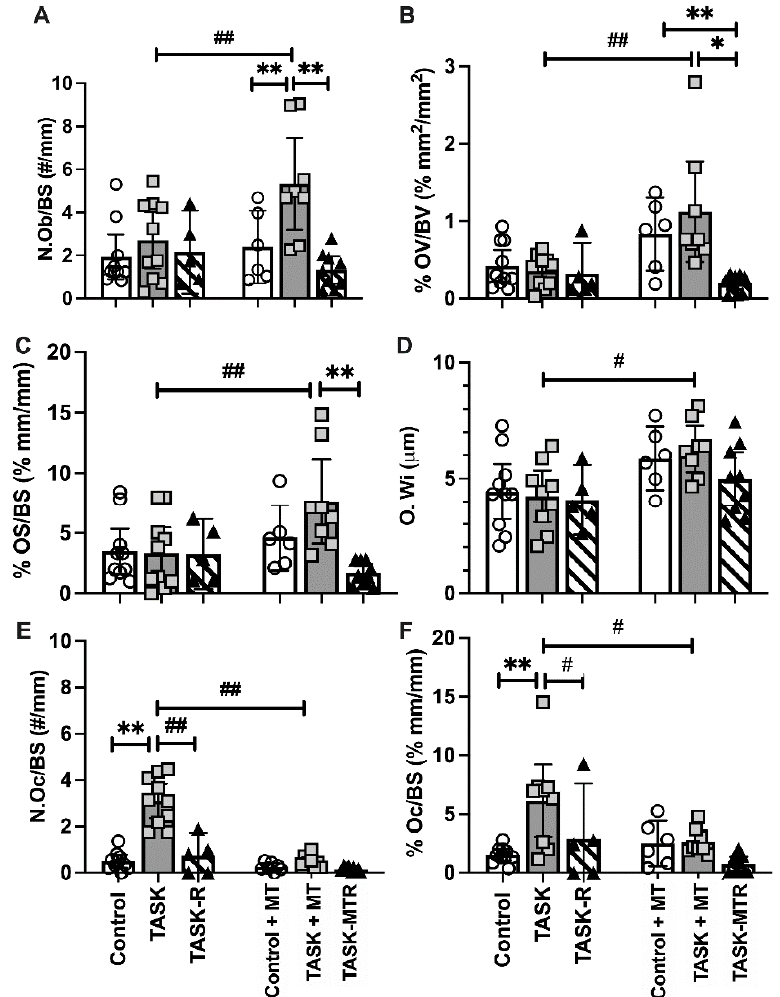
Figure 3. Static histomorphometry of osteoblast and osteoclast parameters in the distal radial metaphyseal trabecular bone. This was performed in a region located 150 µ m below the chondro-osseous junction of the secondary spongiosa and 50 µ m in from the surrounding cortical bone. ( A – F ) Number of osteoblasts per bone surface (N.Ob/BS), percent osteoid volume normalized to bone volume (% OV/BV), percent osteoid surface normalized to bone surface (% OS/BS), osteoid width (O.Wi), number of osteoclasts per bone surface (N.Oc/BS), percent osteoclast surface normalized to bone surface (% Oc.S/BS). Mean ± 95% confidence intervals (CIs) shown. Abbreviations: control rats (Control); 12-week TASK rats (TASK); TASK rats that rested for 6 weeks after task cessation (TASK-R); control rats that received manual therapy for 12 weeks (Control+MT); TASK rats that simultaneously received manual therapy for 12 weeks (TASK+MT); TASK rats that rested for 6 weeks after task cessation while receiving manual therapy treatment of their upper limbs three times per week (TASK-MTR). # and ##: p < 0.05 and p < 0.01, respectively, compared to the TASK group. * and **: p < 0.05 and p < 0.01, respectively, compared between groups as shown.